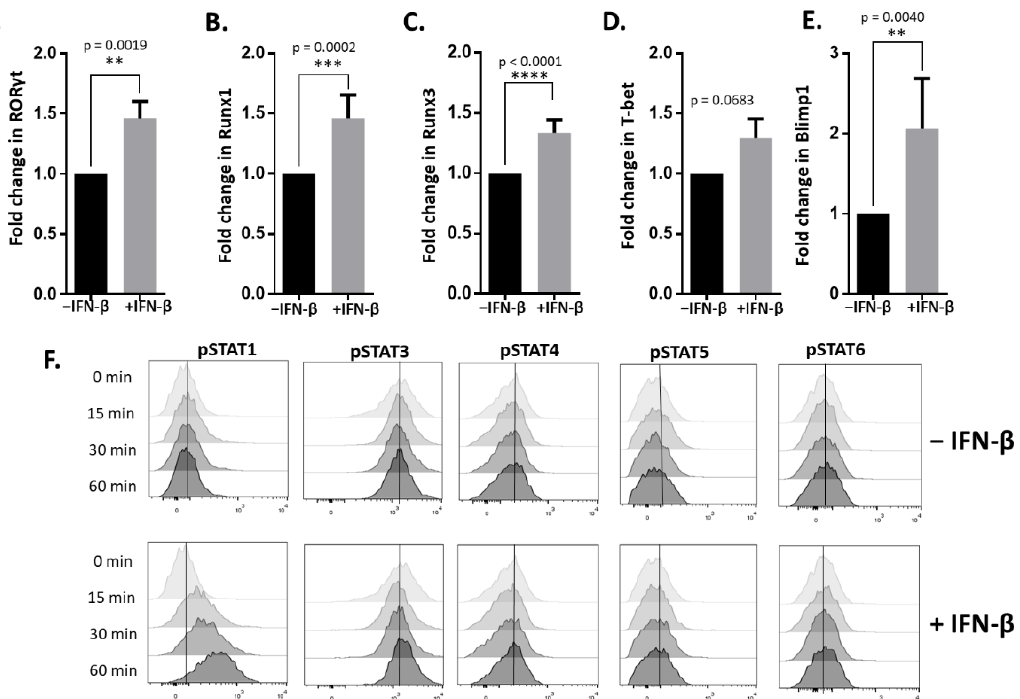
Figure 3. Transcriptional differences in pathogenic IL-23-stimulated TH17 cells induced by IFN-β treatment. Spleen and lymph node cells from MOG 35–55 -immunized C57BL/6J mice were cultured with MOG 35–55 , IL-23 and anti-IFN-γ in the presence or absence of IFN-β for three days. Gene expression was measured by qRT-PCR for the transcription factors; ( A ) RORγt, ( B ) Runx1, ( C ) Runx3, ( D ) T-bet and ( E ) Blimp-1. Cells from the spleen and lymph nodes of MOG-immunized mice were stimulated with MOG 35–55 , anti-IFN-γ, IL-23 ± IFN-β for 0, 15, 30 and 60 min. CD4 + T cells were assessed for phosphorylation of ( F ) STAT1, STAT3, STAT4, STAT5 and STAT6 using flow cytometry. The results are representative of two to four independent experiments. Statistical analysis was determined using Mann−Whitney tests. p values < 0.05 were considered significant (**** indicates p < 0.0001, *** indicates p < 0.001, ** indicates p < 0.01).